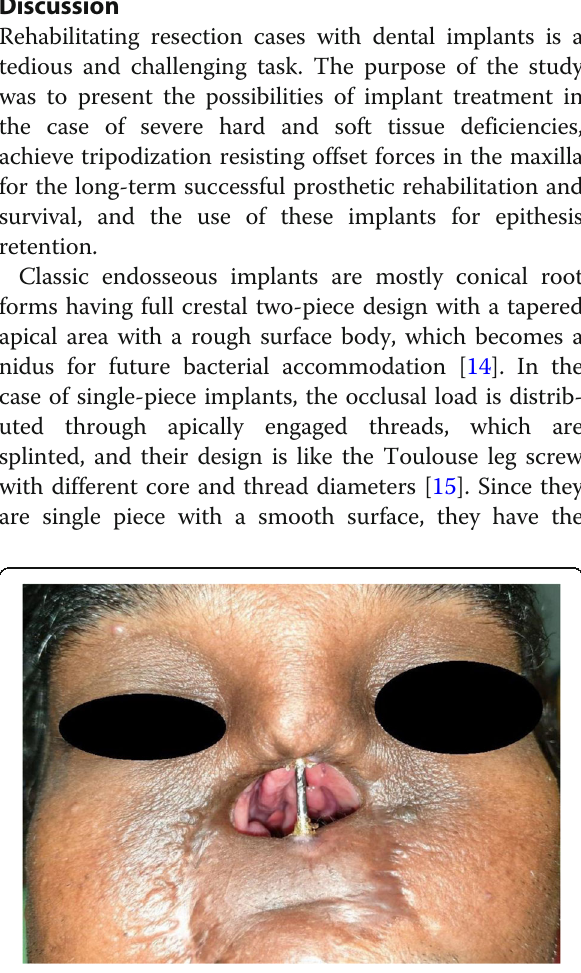
Fig. 8 A post-surgery view of the zygomatic implant placed for the glabella region anchorage after the intraoral prosthesis